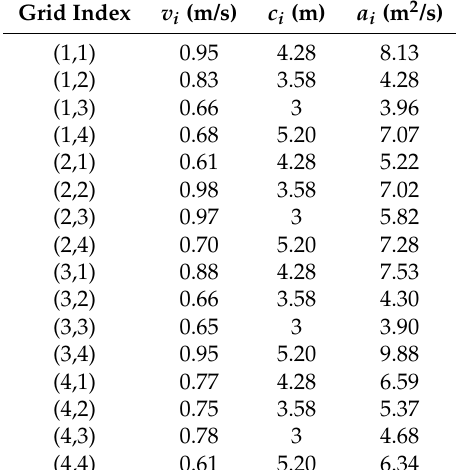
Table 1. This table includes the capabilities of the UAVs involved in the studied scenario, according to their location in the grid: flying velocity ( v i ), coverage range ( c i ) and sensing coverage ( a i = 2 c i v i ).